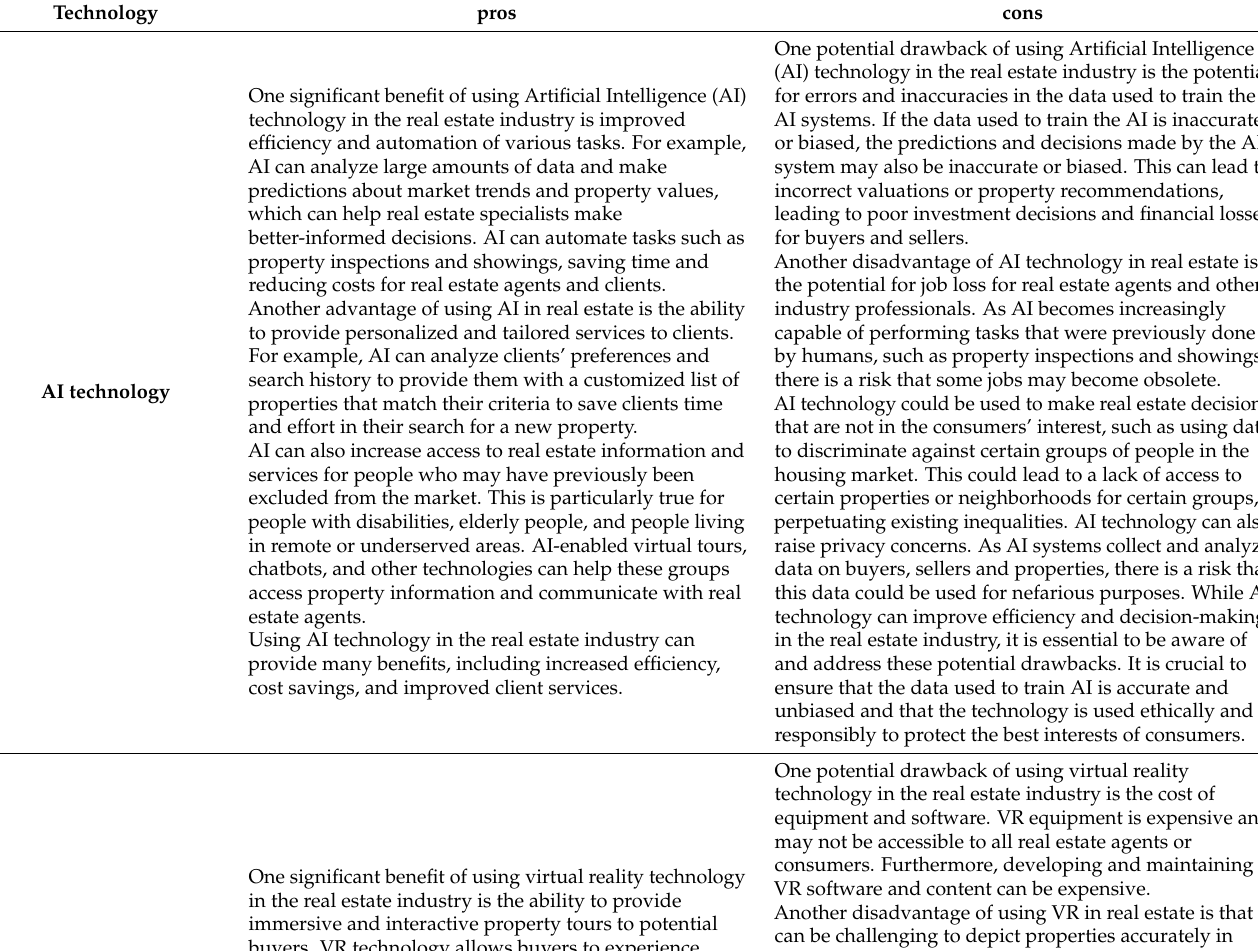
Table 1. Advantages and Disadvantages of VR and AI in Real